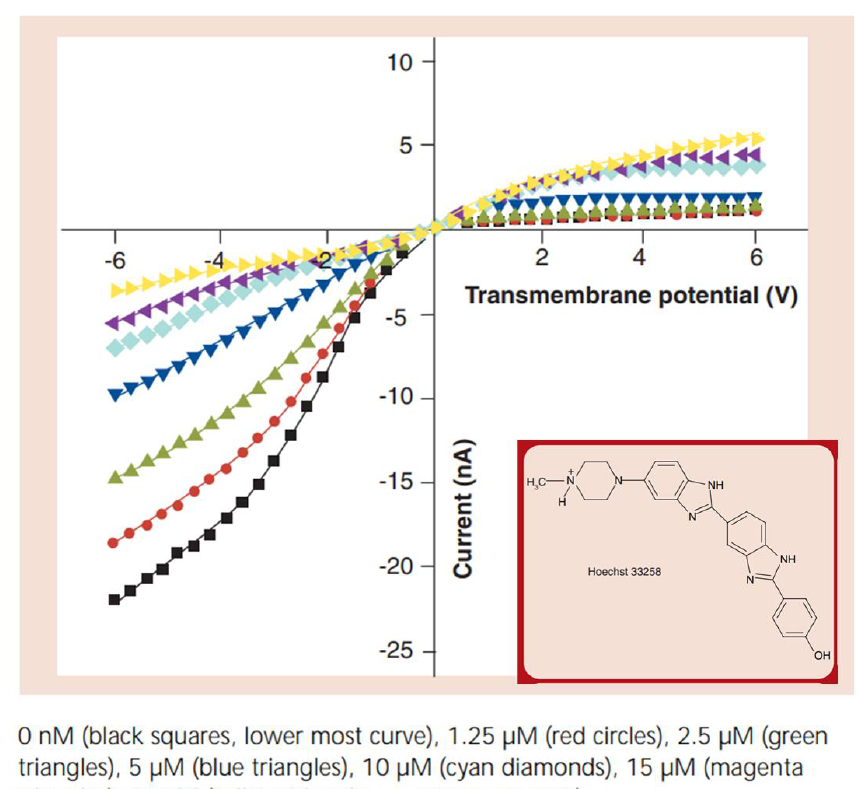
Figure 4. Rectified I–V curve in the presence of various concentrations of Hoechst 33258. Reprinted and adapted with permission from [26]. Copyright 2008, Future Medicine.